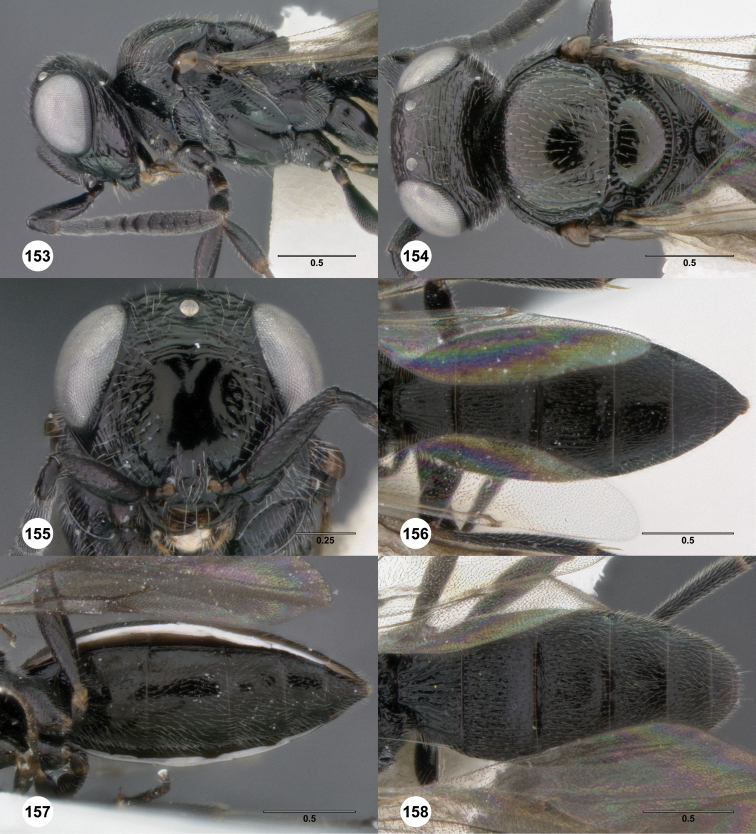
Oxyscelio leviventris sp. n., paratype female (OSUC 438829) 153 Head and mesosoma, lateral view 154 Head and mesosoma, dorsal view 155 Head, anterior view. Holotype female (OSUC 438828) 156 Metasoma, dorsal view 157 Metasoma, ventral view. Paratype male (OSUC 438832) 158 Metasoma, dorsal view. Morphbank57